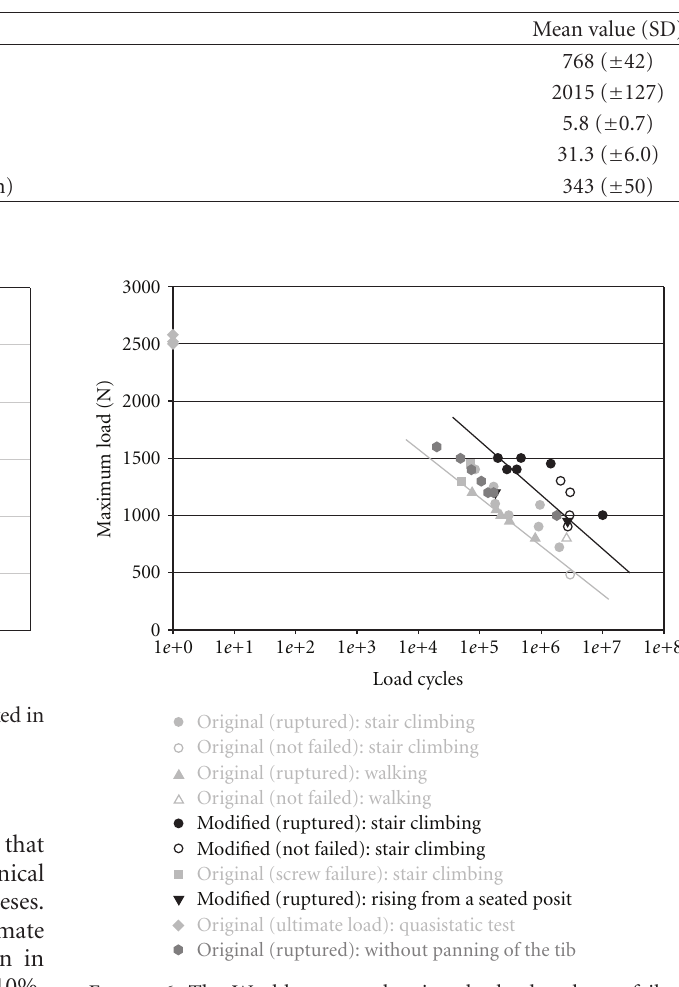
Figure 6: The Woehler curve showing the load cycles to failure for the two di ff erent fixation blocks (originally and modified) and di ff erent loading